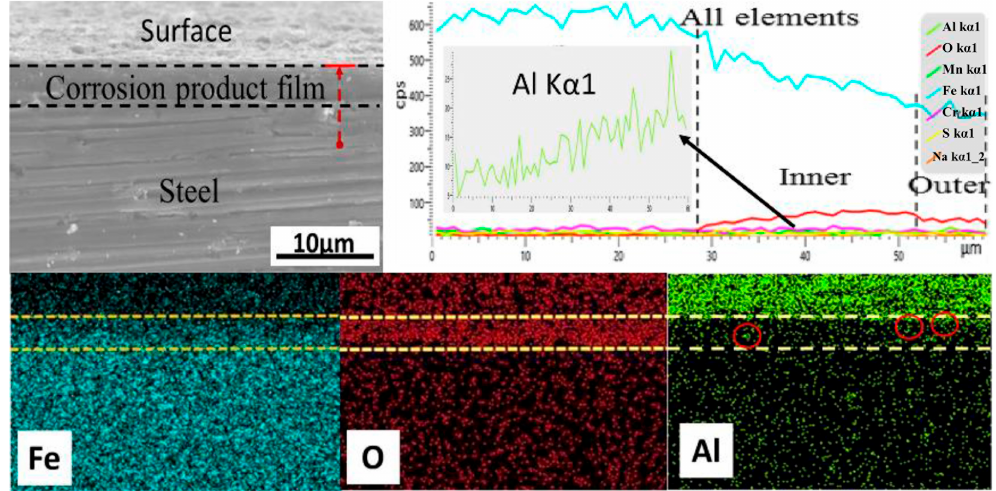
Figure 8. Morphologies, elemental mapping, and line scan of the cross-section of the corrosion product film on the 12Cr1MoV steel after 5 d of corrosion in the TCSA solution.